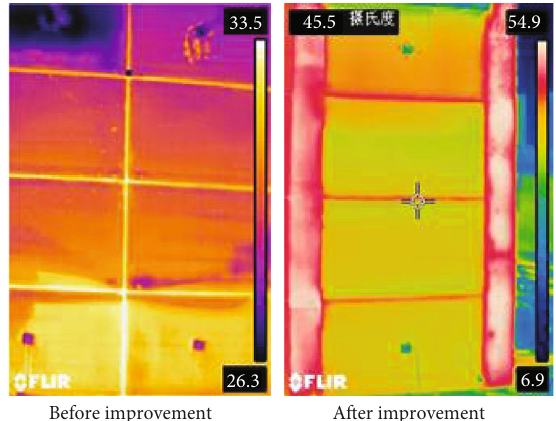
Figure 3: The connection form of the PV/T façade system after